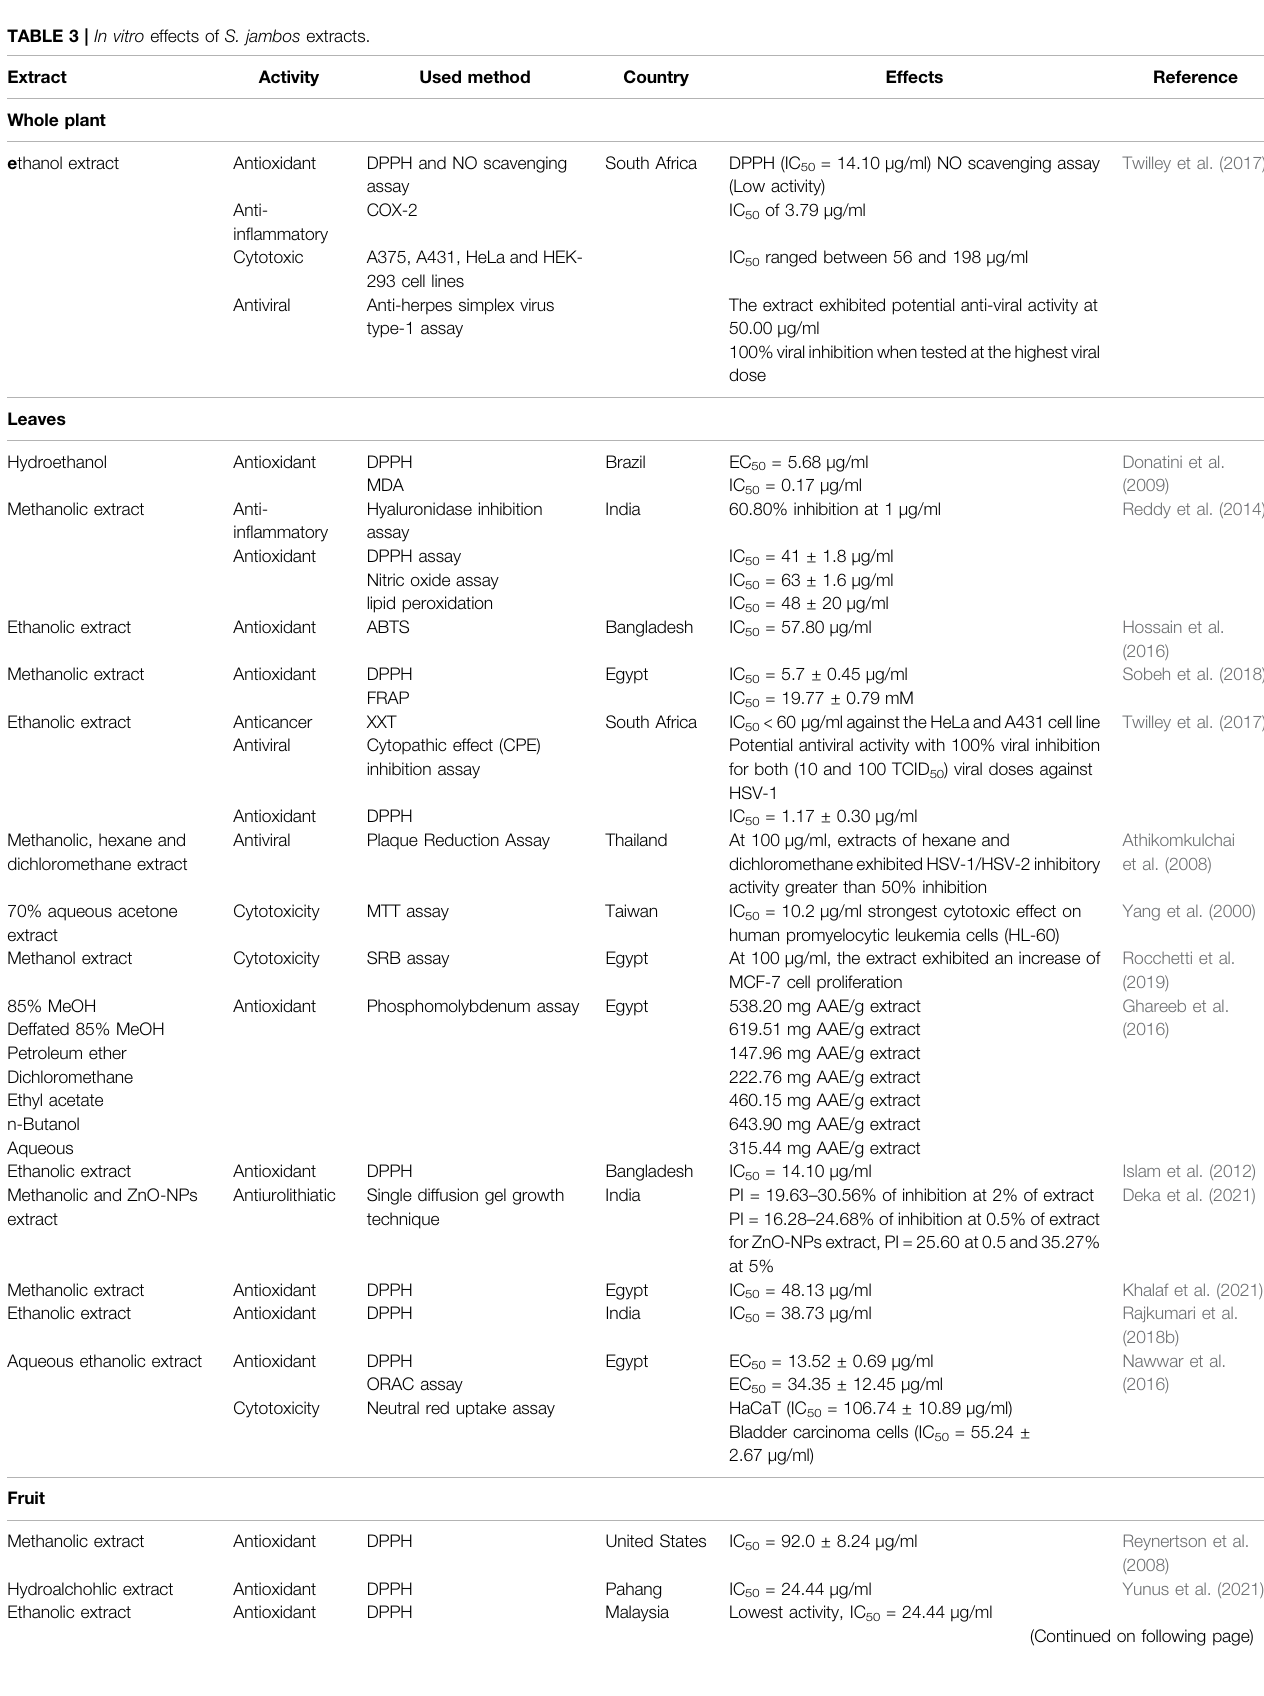
TABLE 3 | In vitro effects of S. jambos